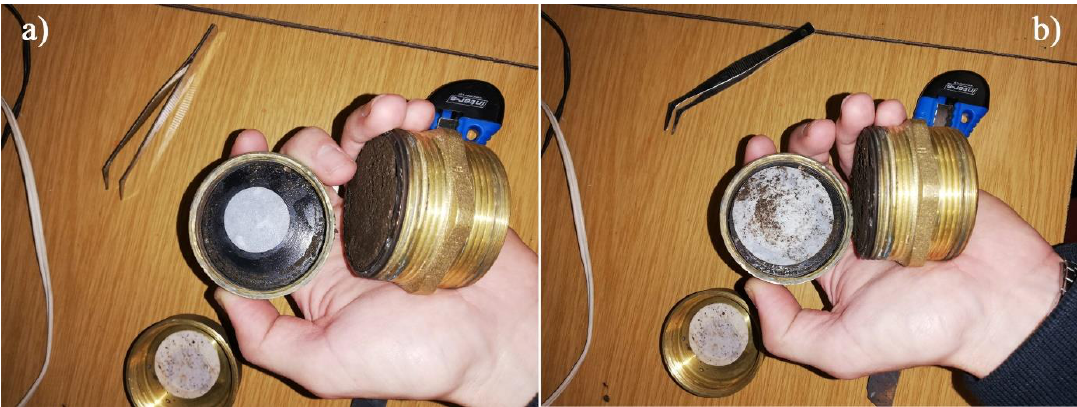
Figure 9. Application of the two concentric paper filters, with diameters of 30 mm ( a ) and 50 mm ( b ).